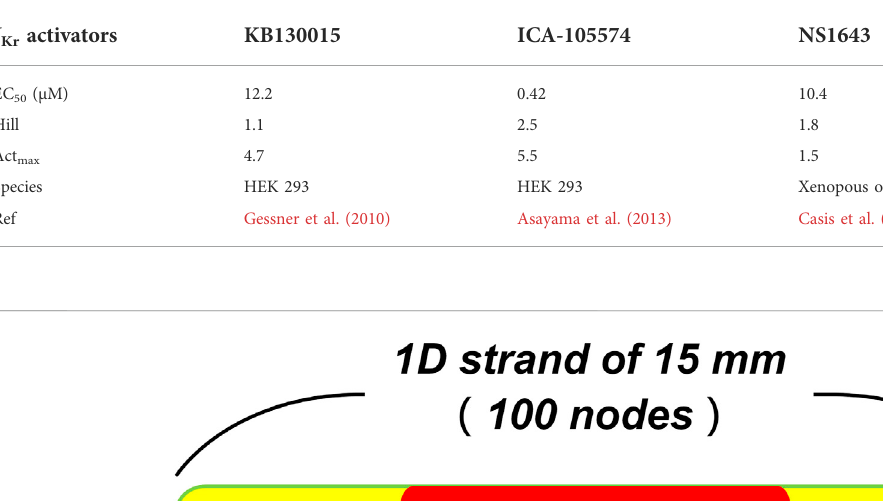
TABLE 4 Summary of data for four speci fi c I Kr activators.